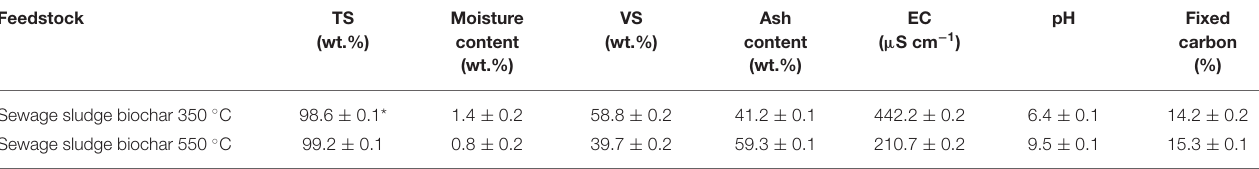
TABLE 5 | Physico-chemical properties of sewage sludge digestate biochars produced at different temperatures ( n = 3)*. Feedstock TS Moisture (wt.%)